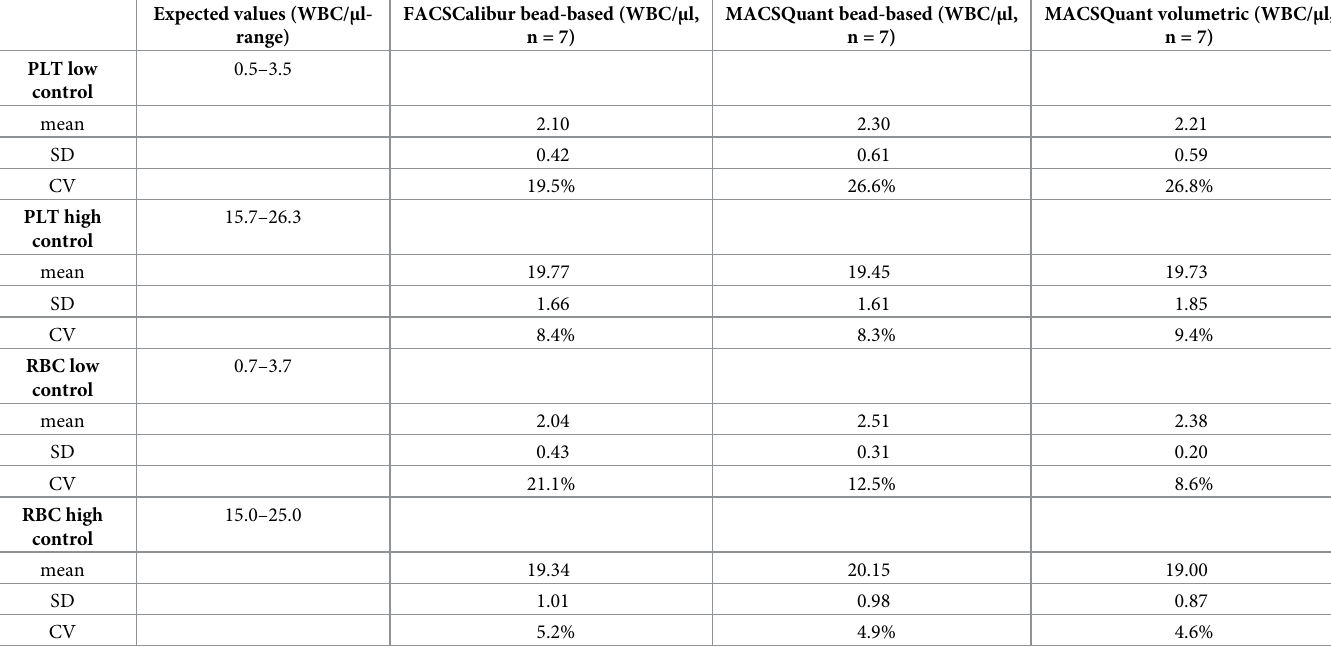
Mean leukocyte counts (mean), standard deviation (SD), and coefficient of variation (CV) were calculated from the results obtained with the bead-based method on the FACSCalibur and MACSQuant 10, and with the volumetric method on the MACSQuant